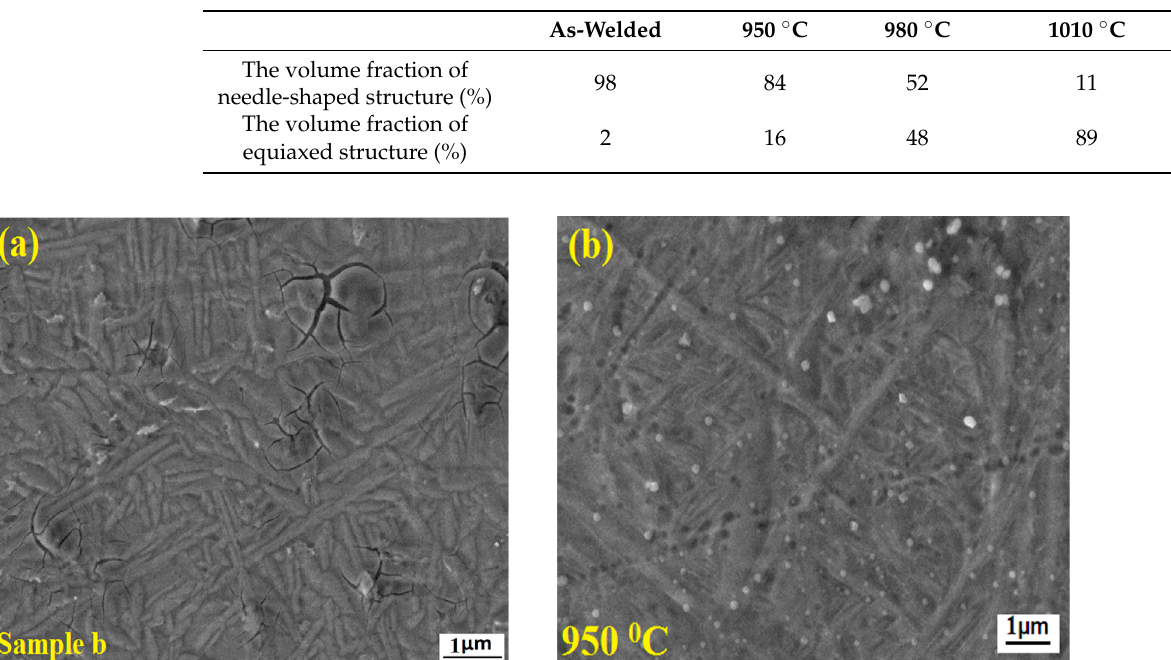
Table 5. Volume fraction under different annealing temperatures.